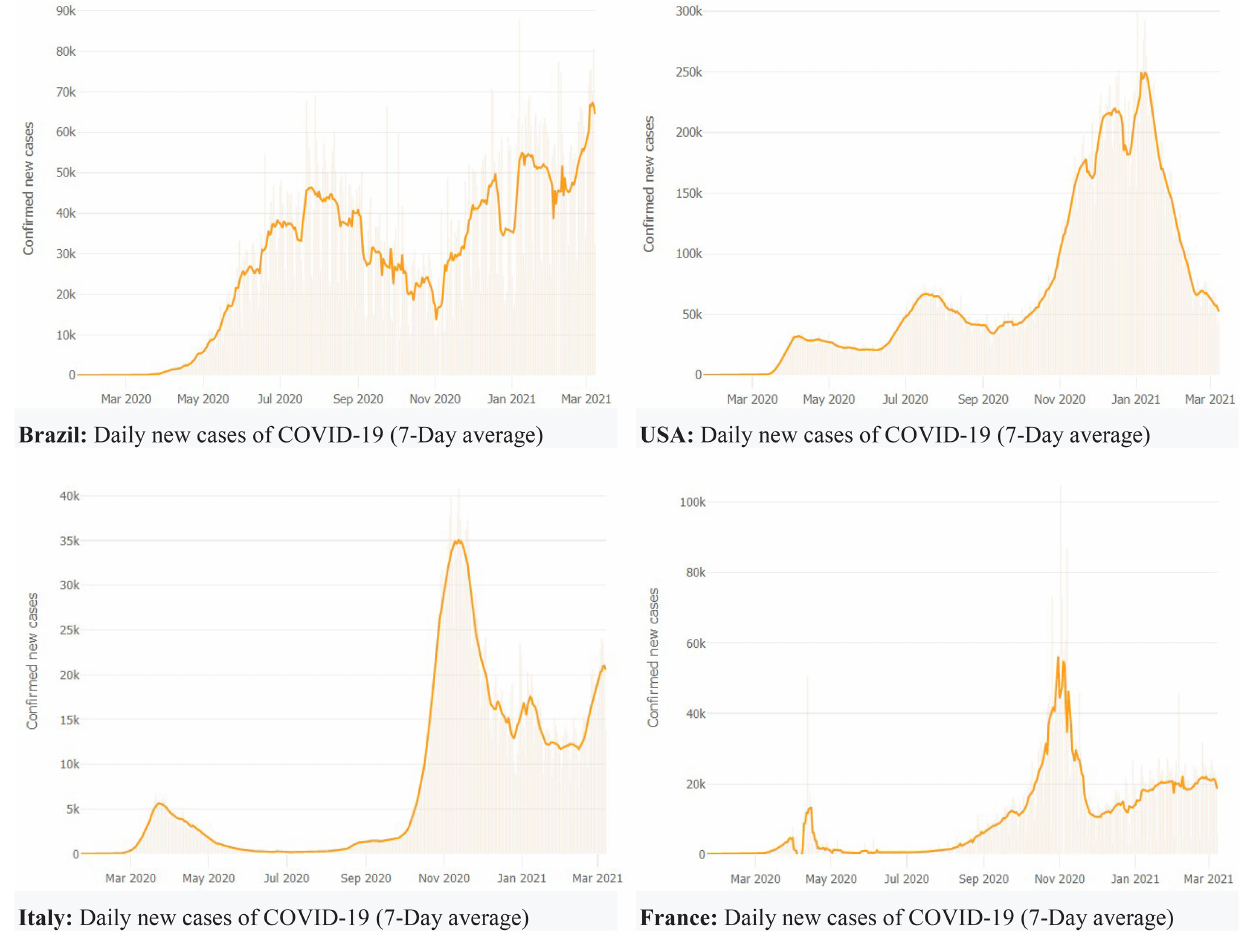
FIGURE 1 | The trend of COVID-19 confirmed cases in Italy and France, as of March 1,